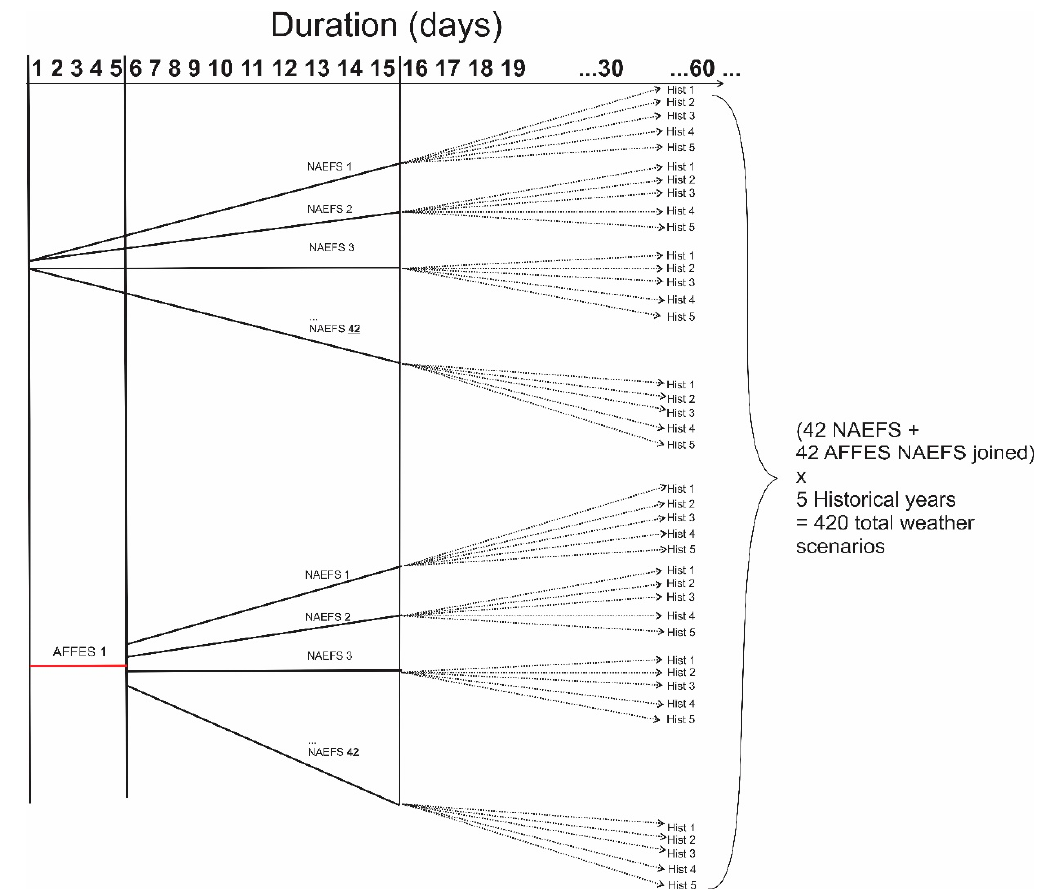
Figure 6. An illustration of the number of distinct forecast scenarios increasing over the forecast horizon.